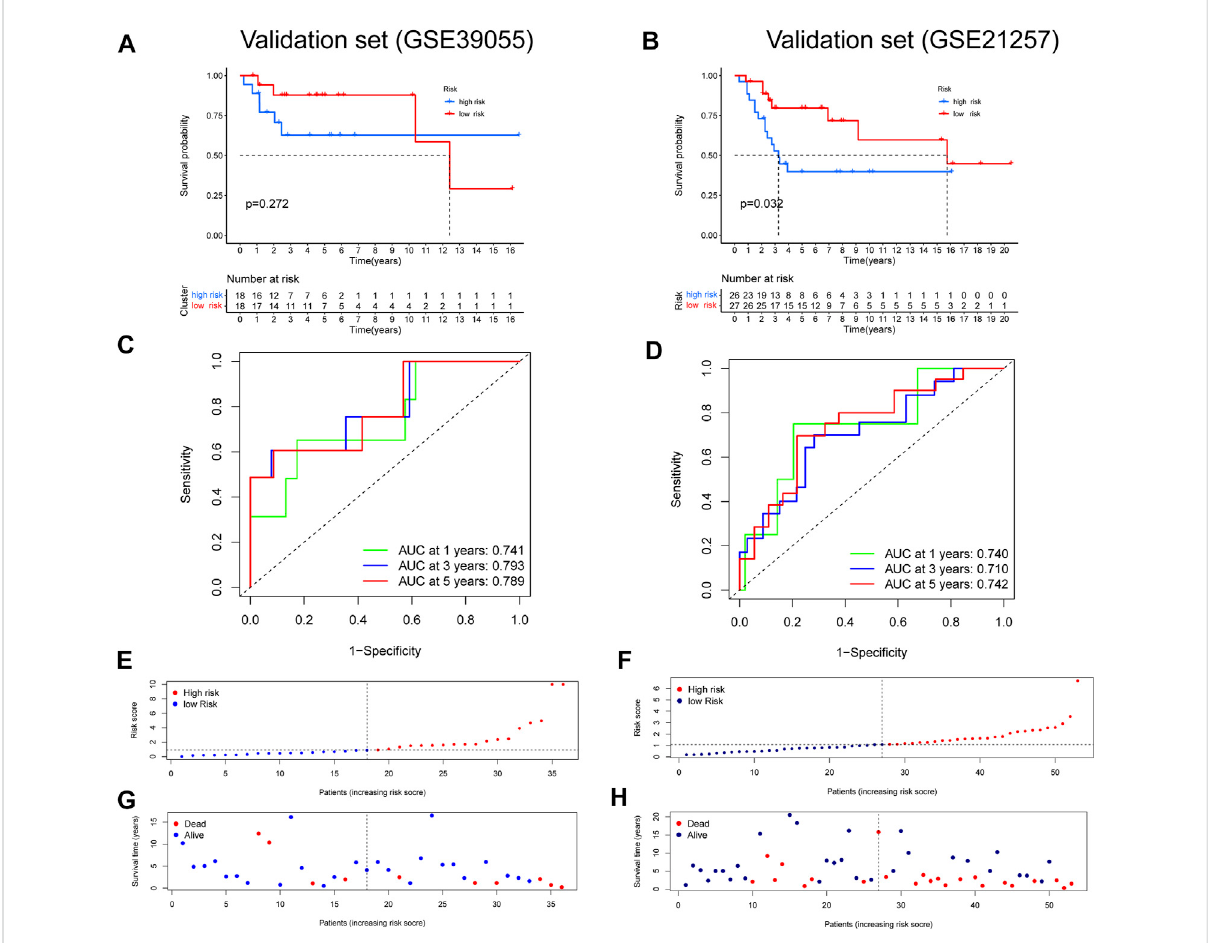
FIGURE 4 Validation of a ubiquitin-related gene signature in two independent cohorts. (A,B) The Kaplan – Meier survival curve in two validation sets. (C,D) The ROC curves in the validation sets. (E-H) Risk score distribution and survival status of OS patients in the validation